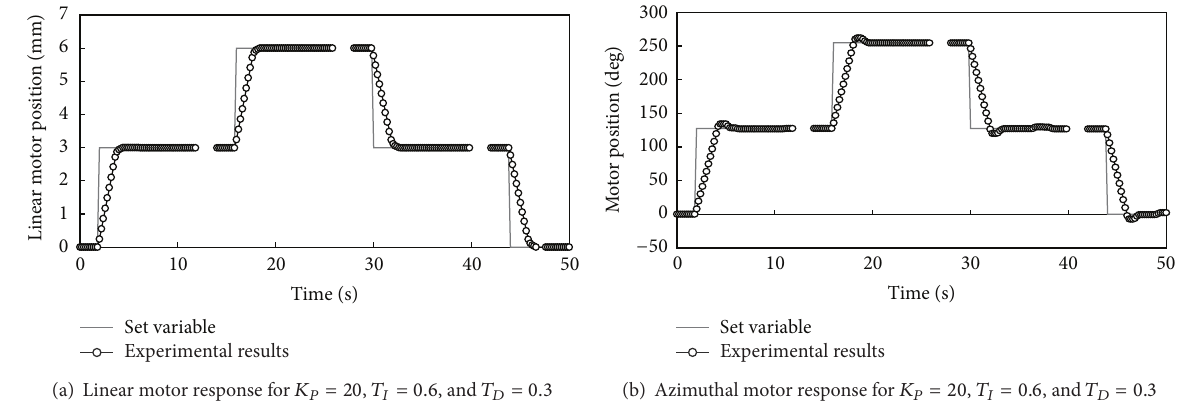
Figure 10: Position step response of the linear and azimuth motors for small